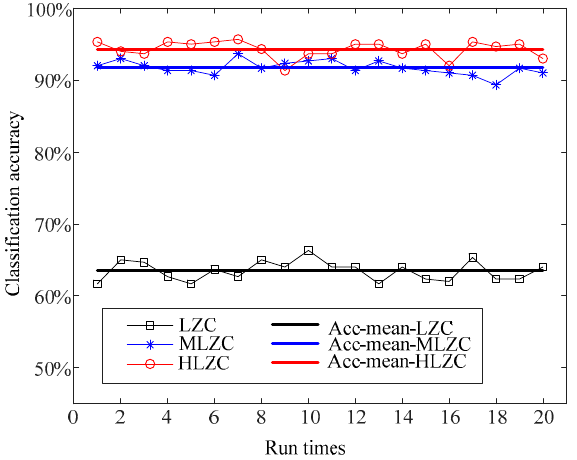
Appl. Sci. 2020 , 10 , x FOR PEER REVIEW Figure 13. Confusion matrix using the proposed HLZC method for Experiment 1. Figure 13. Confusion matrix using the proposed HLZC method for Experiment 1.